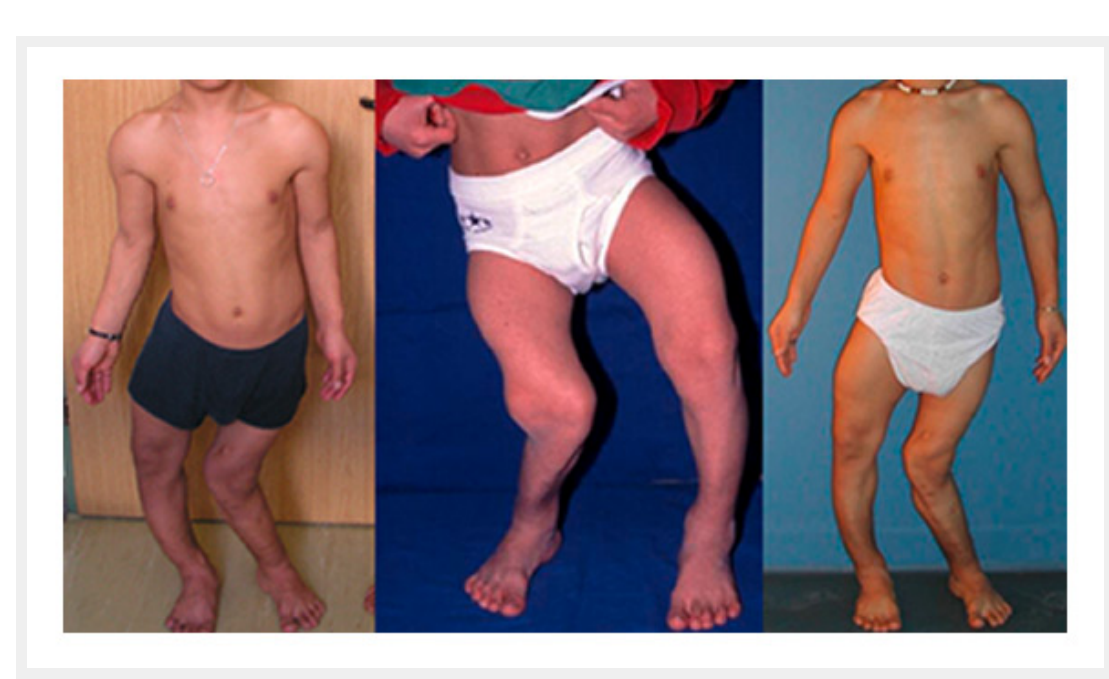
Standing photos of three patients of different ages who presented with windswept deformity (the appearance of an abnormal valgus deformity in one knee in association with varus in the other). Clinically, the average valgus deformity was 35° and the average varus deformity was 22°.